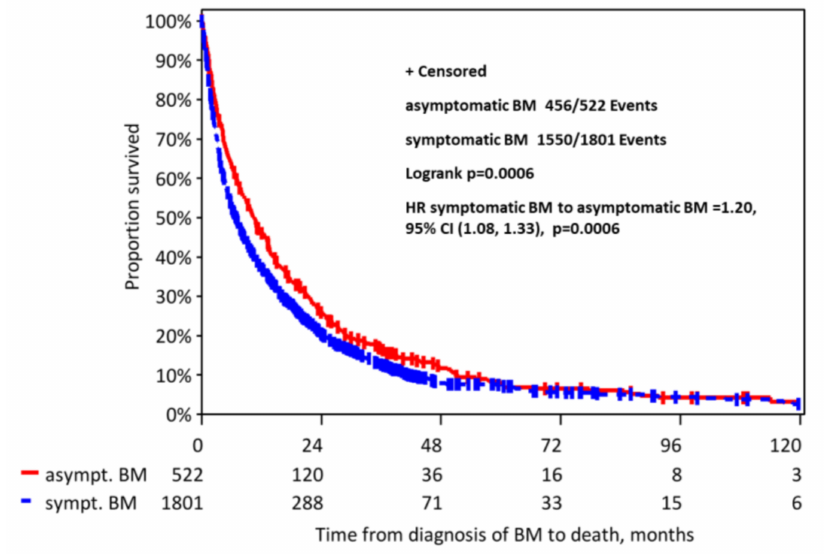
Figure 2. Kaplan-Meier curve for the time from first diagnosis of BM to death due to any